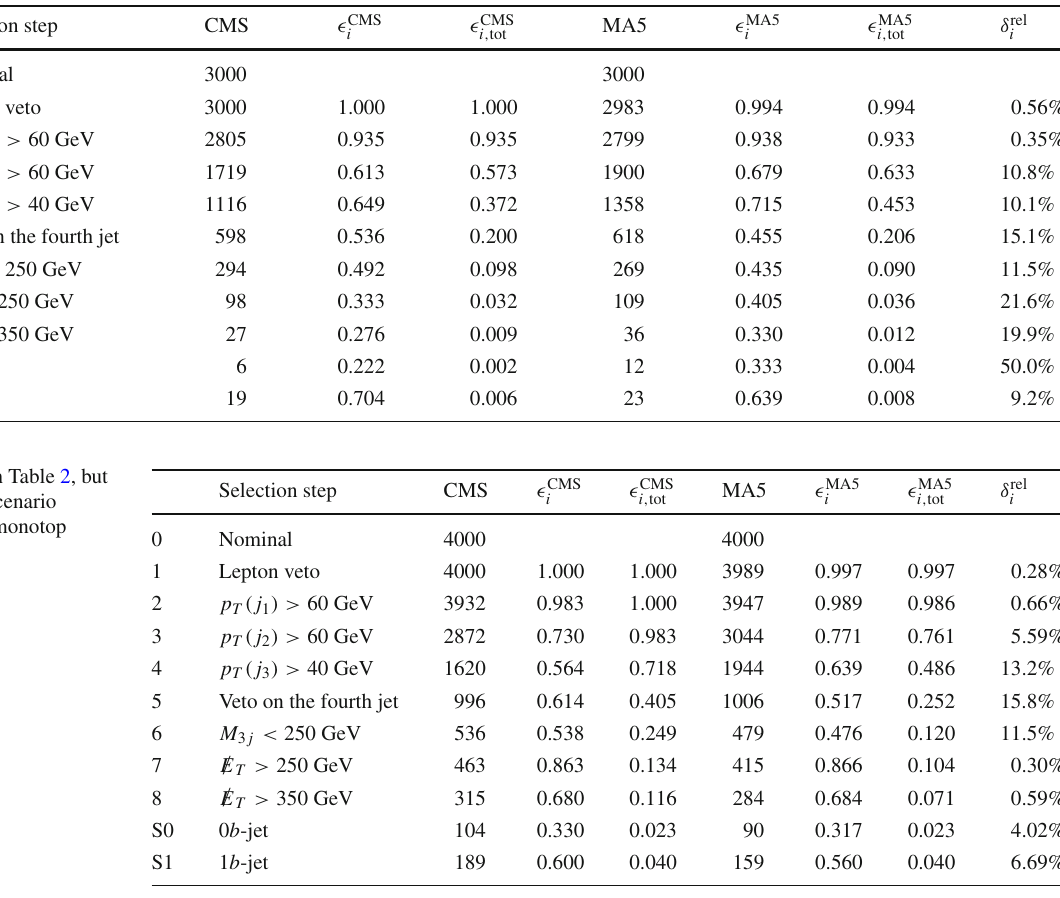
efficiencies are defined in Eq. 15. The official CMS numbers have been derived from the same hard-scattering events entering our simulation chain. Those events have been provided to the CMS collaboration who accepted to produce an official cutflow